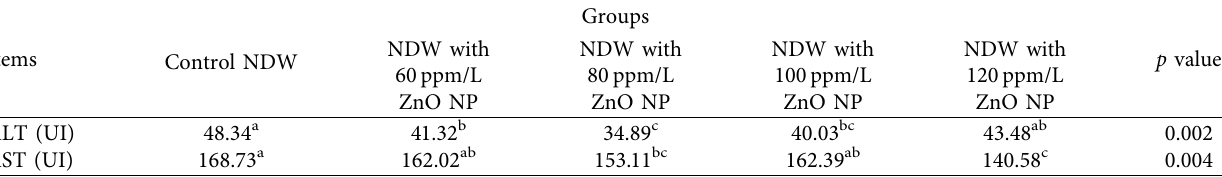
Table 6: Efect of zinc oxide nanoparticles (ZnO NPs) on liver enzyme activity at 42 days of age. Items